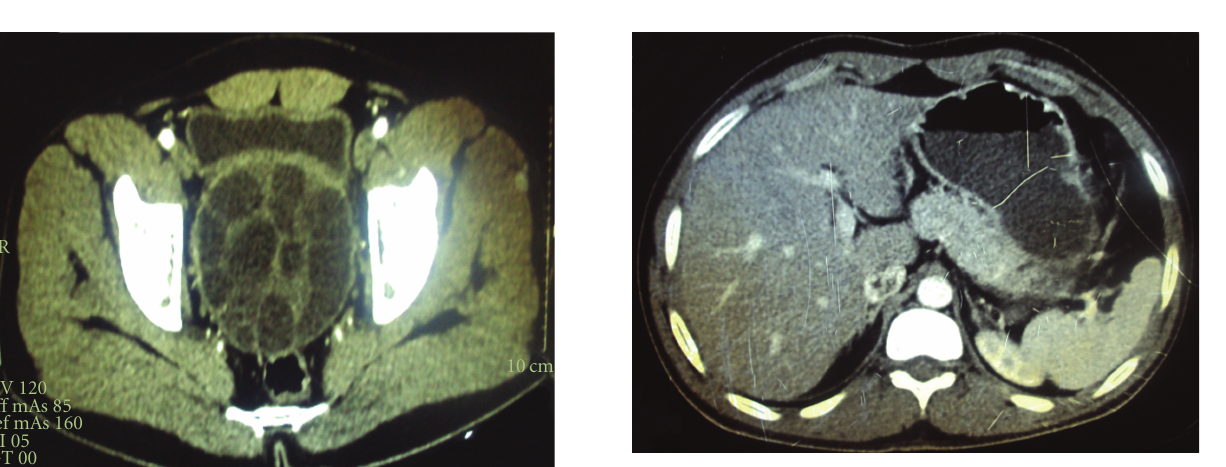
Figure 3: CT showing no involvement of the